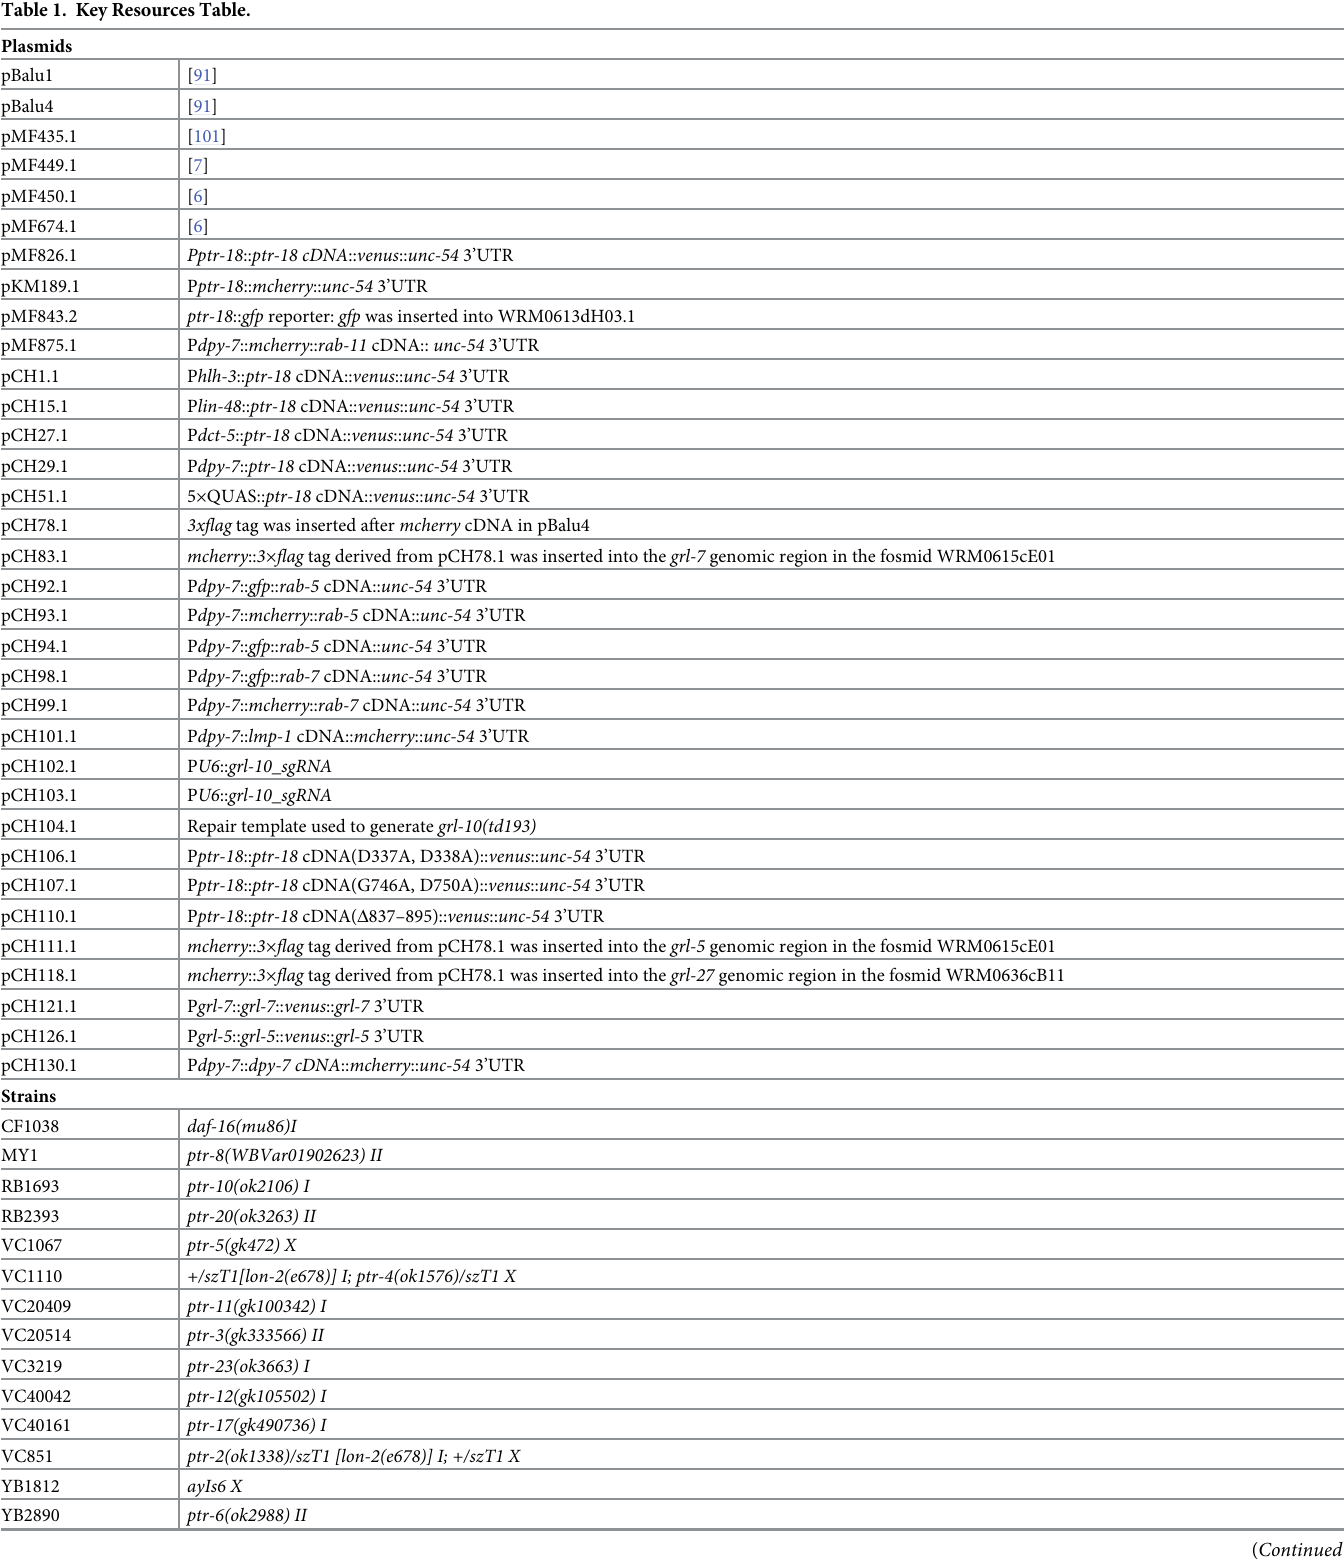
Table 1. Key Resources